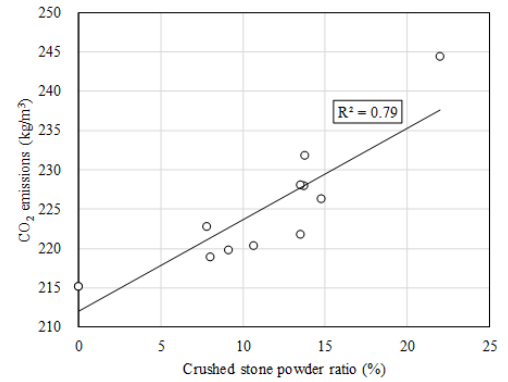
Figure 12. CO 2 emissions.